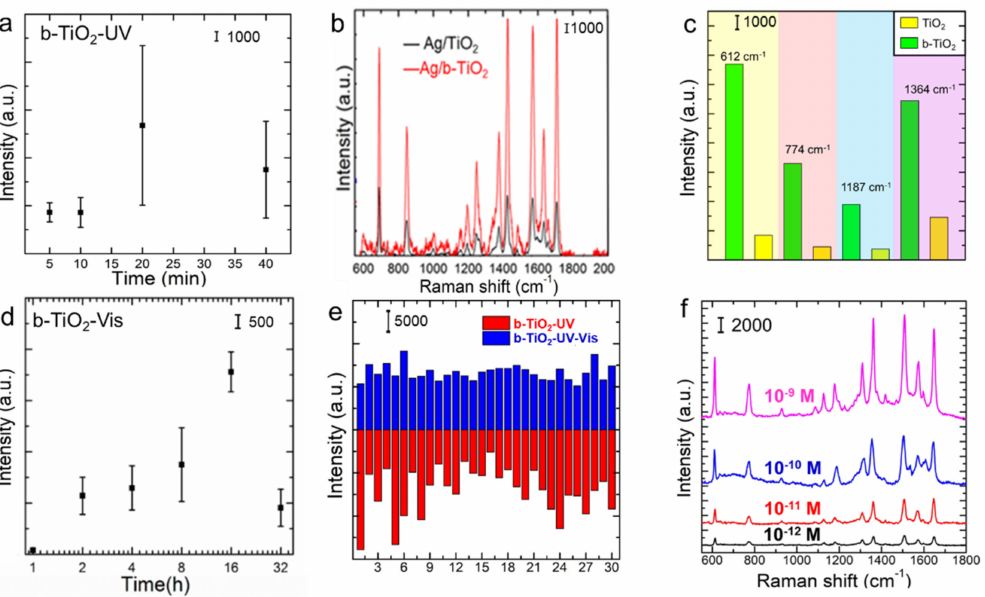
Figure 4. SERS performance of Ag/b-TiO 2 . ( a ) The SERS sensitivities of Ag/b-TiO 2 -UV with different synthesis times. ( b , c ) The comparison of SERS sensitivities between Ag/b-TiO 2 and Ag/TiO 2 . ( d ) The SERS sensitivities of Ag/b-TiO 2 -Vis with different synthesis times. ( e ) The homogeneity characterizations of Ag/b-TiO 2 -UV and Ag/b-TiO 2 -UV-Vis. ( f ) SERS detection of R6G molecules with concentrations ranging from 10 − 9 to 10 − 12